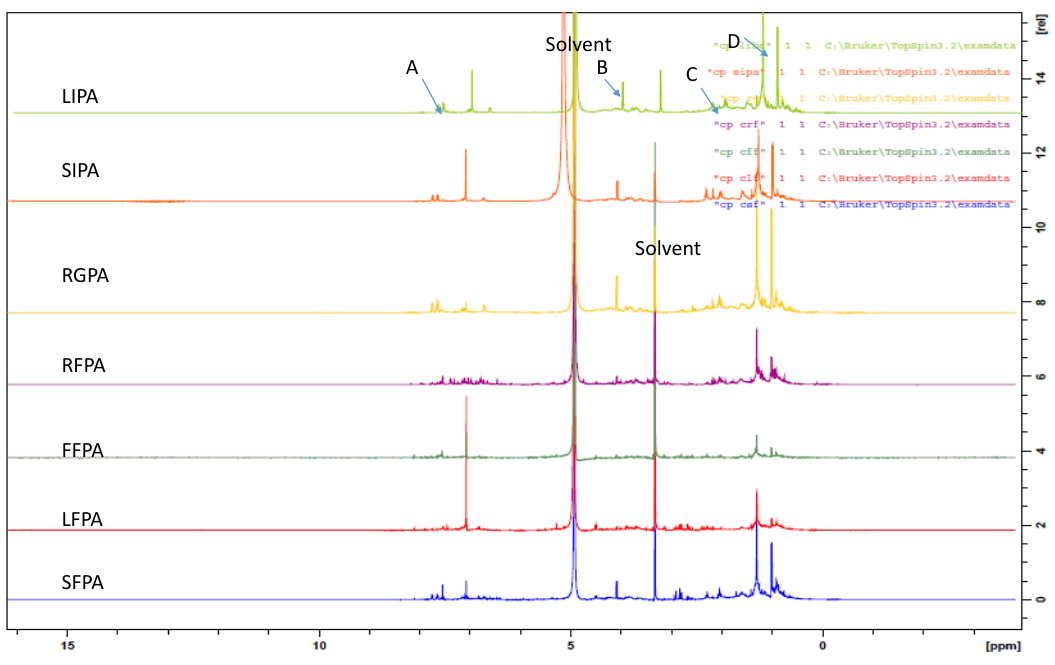
Figure 5. The 1 H - NMR spectra indicating the chemical shifts identical to Pthalates. Figure 5. The 1 H-NMR spectra indicating the chemical shifts identical to